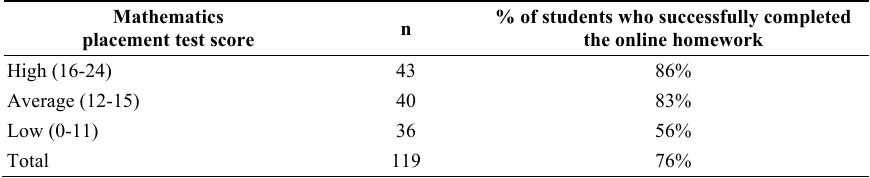
Table 3. Completion of online homework and exam success for different incoming